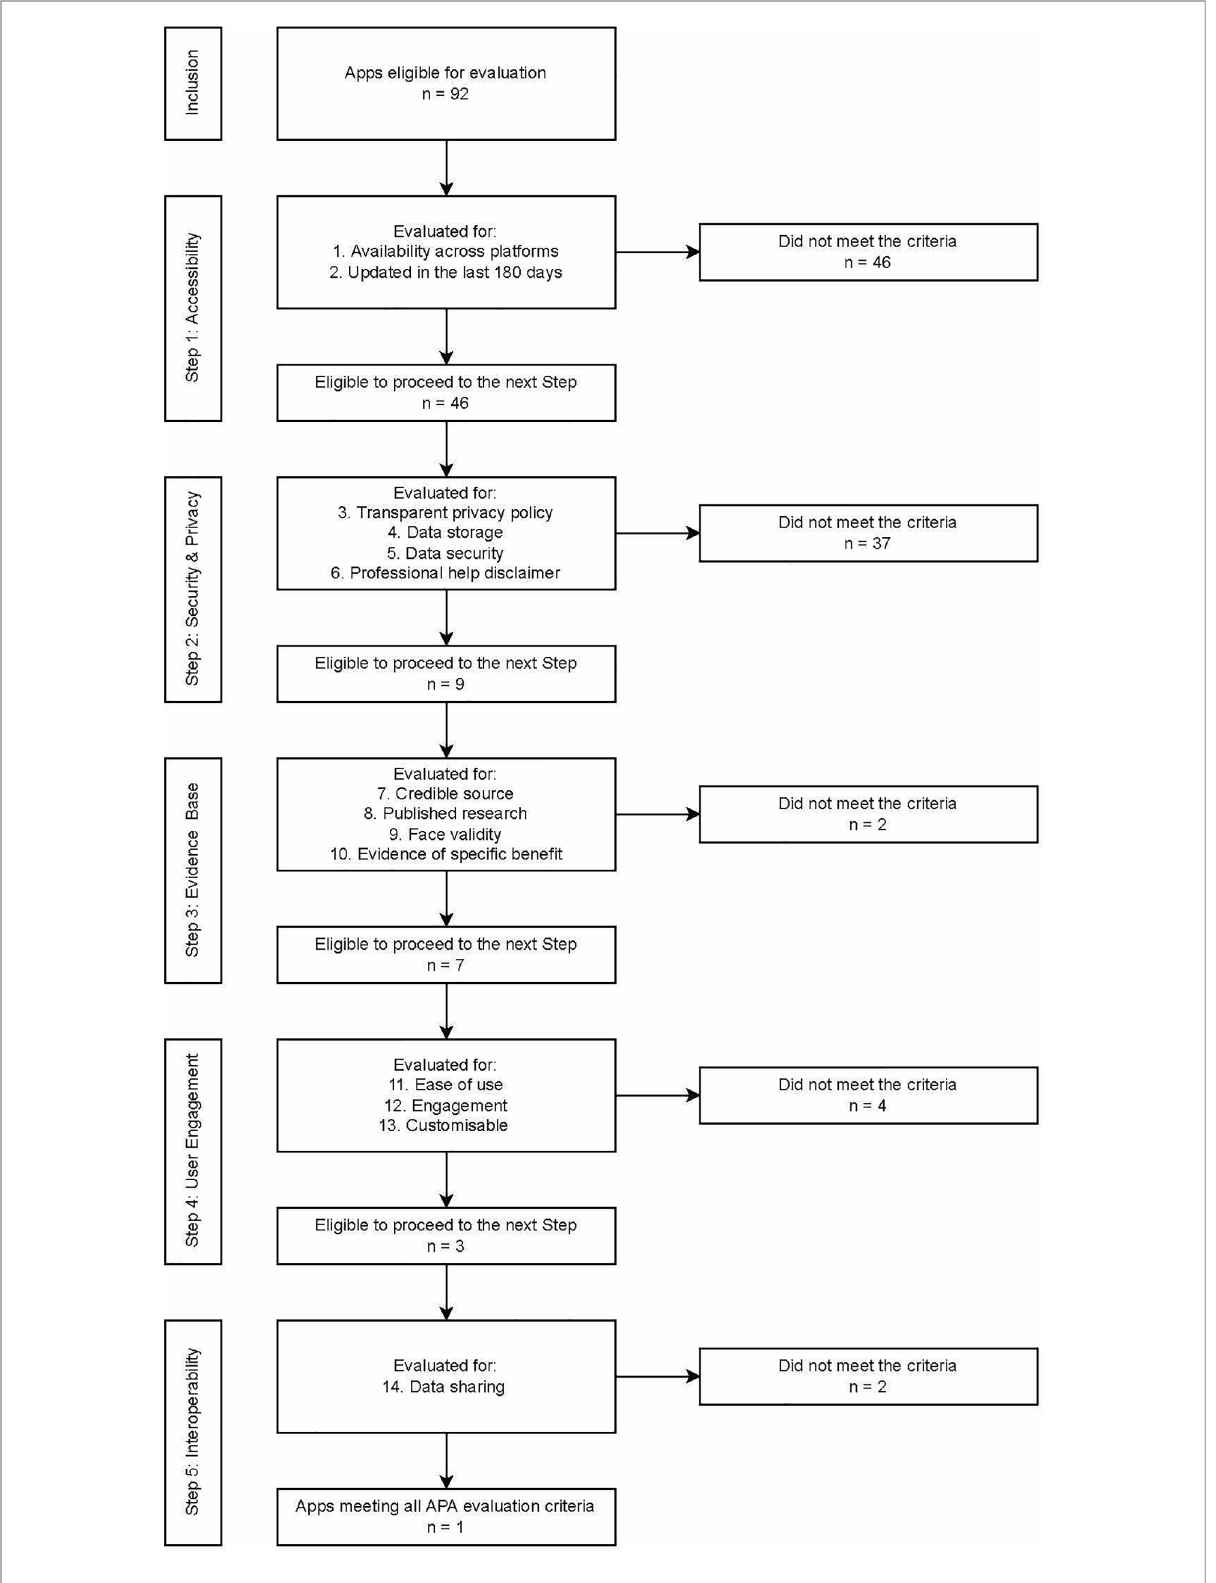
FIGURE 4 Progression of 92 apps across each evaluation